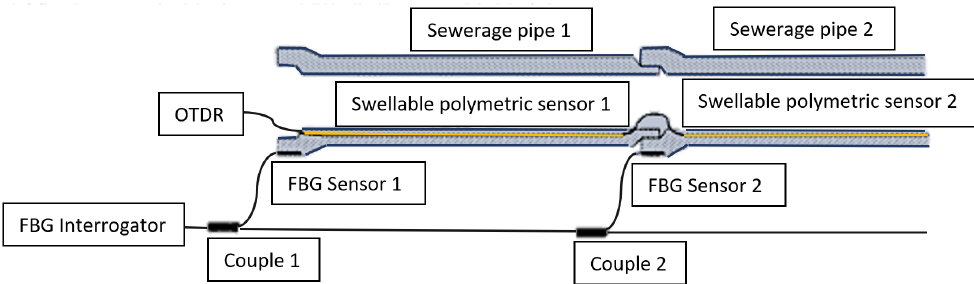
Figure 4. A Fiber optic sensor system diagram for finding water leaks in sewer tunnels. FBG humidity sensors are used at the intersection of two sewage lines and fiber optic swellable polymeric sensors are applied along the sewerage tunnel